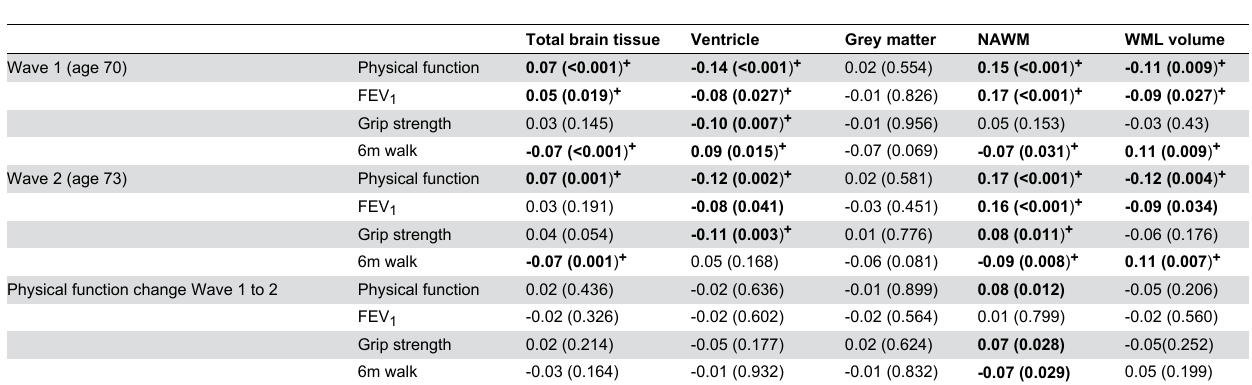
Note. Physical function factor = the general factor produced from PCA of the three measures of physical function. Values are the standardized β (and p value) for the listed physical function measure predicting the brain volume measures after accounting for all the covariates in the model (see Tables S1-S4 for intermediate models and the standardized β of the covariates). The models were also repeated with the physical function measures at age 73 adjusted for the relevant age 70 physical function measure as dependent variables, essentially a measure of 3-year change in physical function. The covariates included were age, ICV, age-11 IQ, years of education, social class, history of cardiovascular disease, diabetes, hypertension and stroke, and current smoking status. + represent associations that remained significant after applying a correction for false discovery